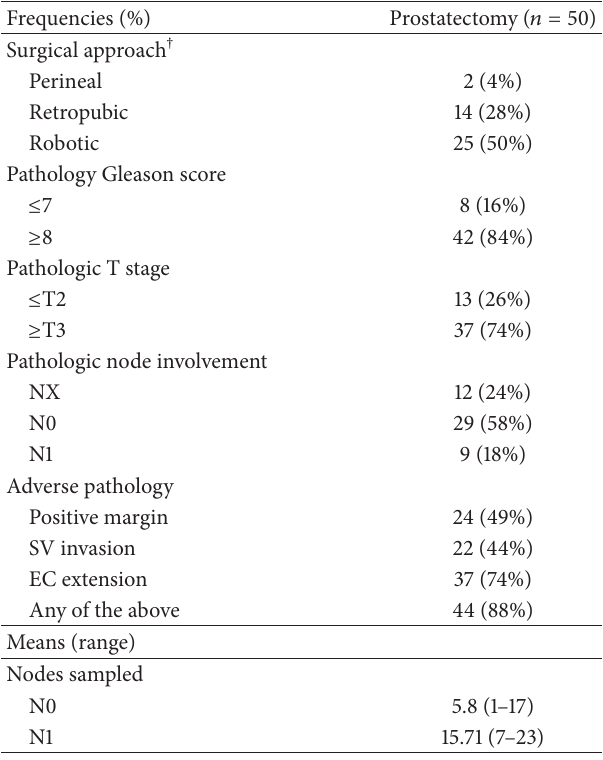
Table 2: Surgical and pathologic characteristics of prostatectomy